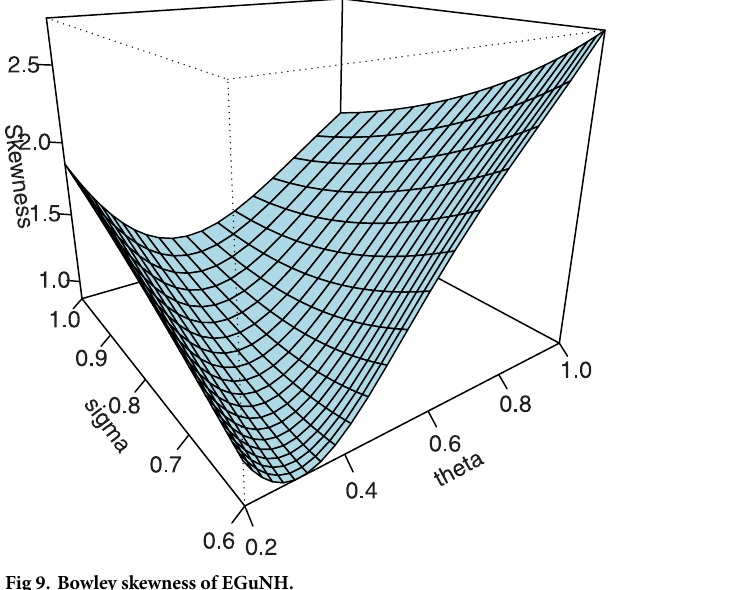
Fig 9. Bowley skewness of